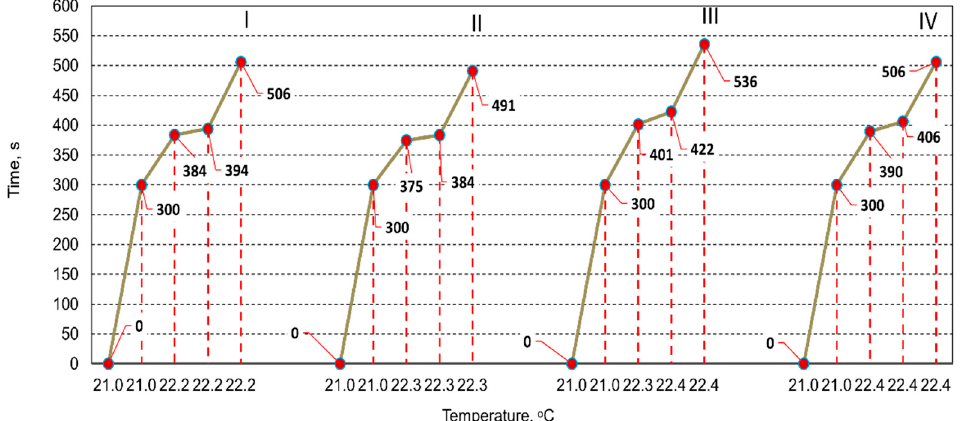
Figure 13. Time characteristics of individual combustion stages of a fir tree sample conditioned by a pulsed electric field: I (electric field intensity 25 kV · cm − 1 and number of pulses 150); II (electric field intensity 25 kV · cm − 1 and number of pulses 300); III (electric field intensity 30 kV · cm − 1 and number of pulses 150); IV (electric field intensity 30 kV · cm − 1 and number of pulses 300).